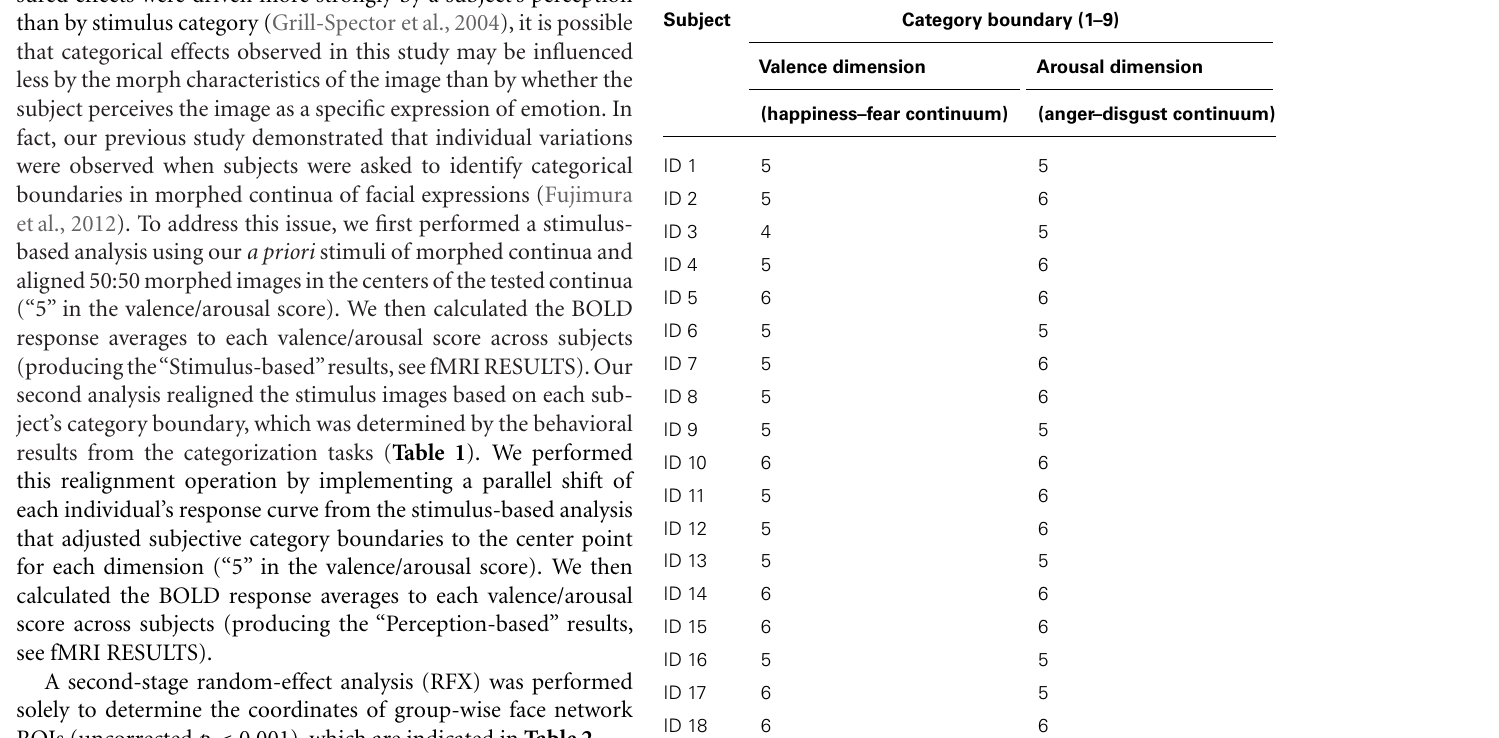
Table 1 | Individual category boundaries for each